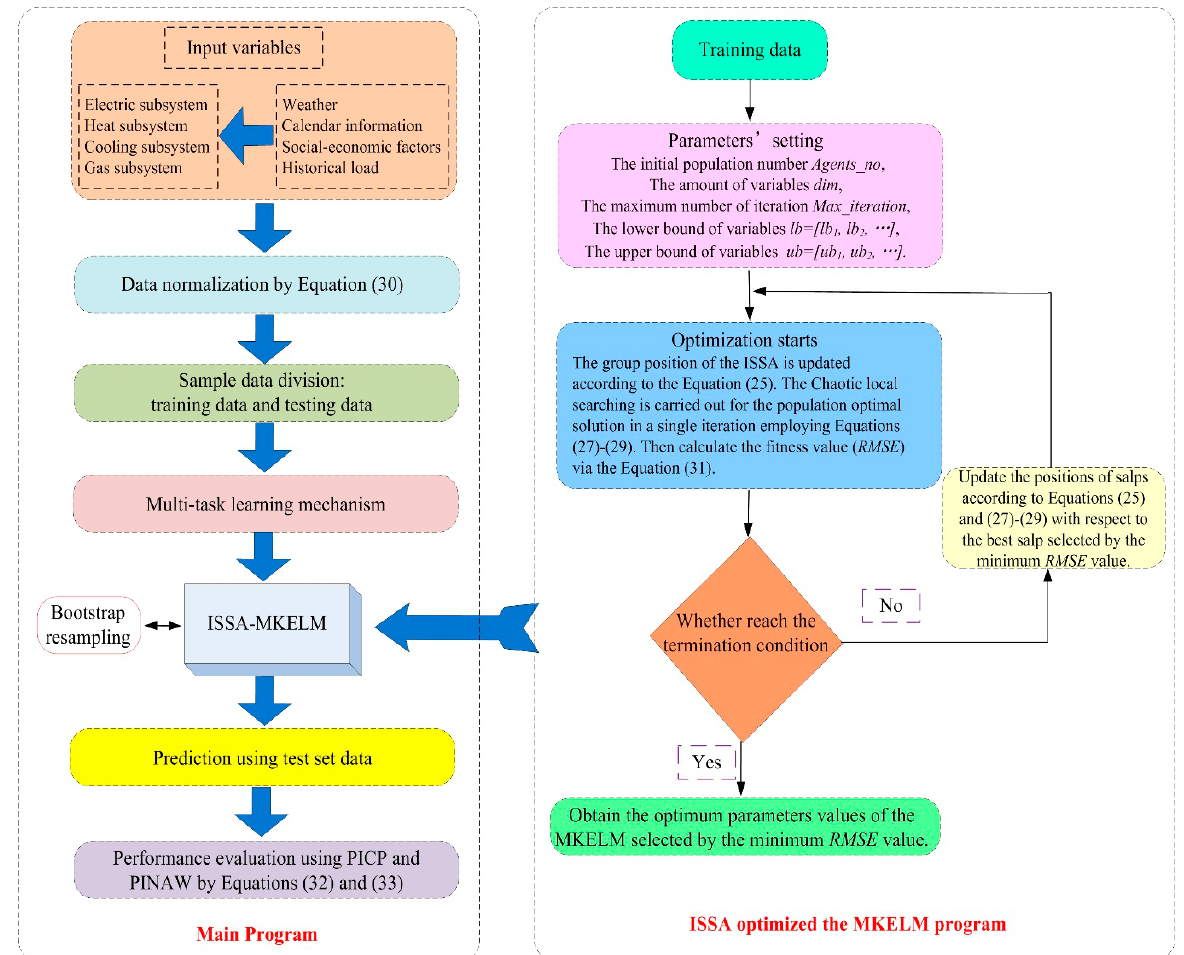
Figure 8. The calculation process of the established uncertain interval forecasting model.